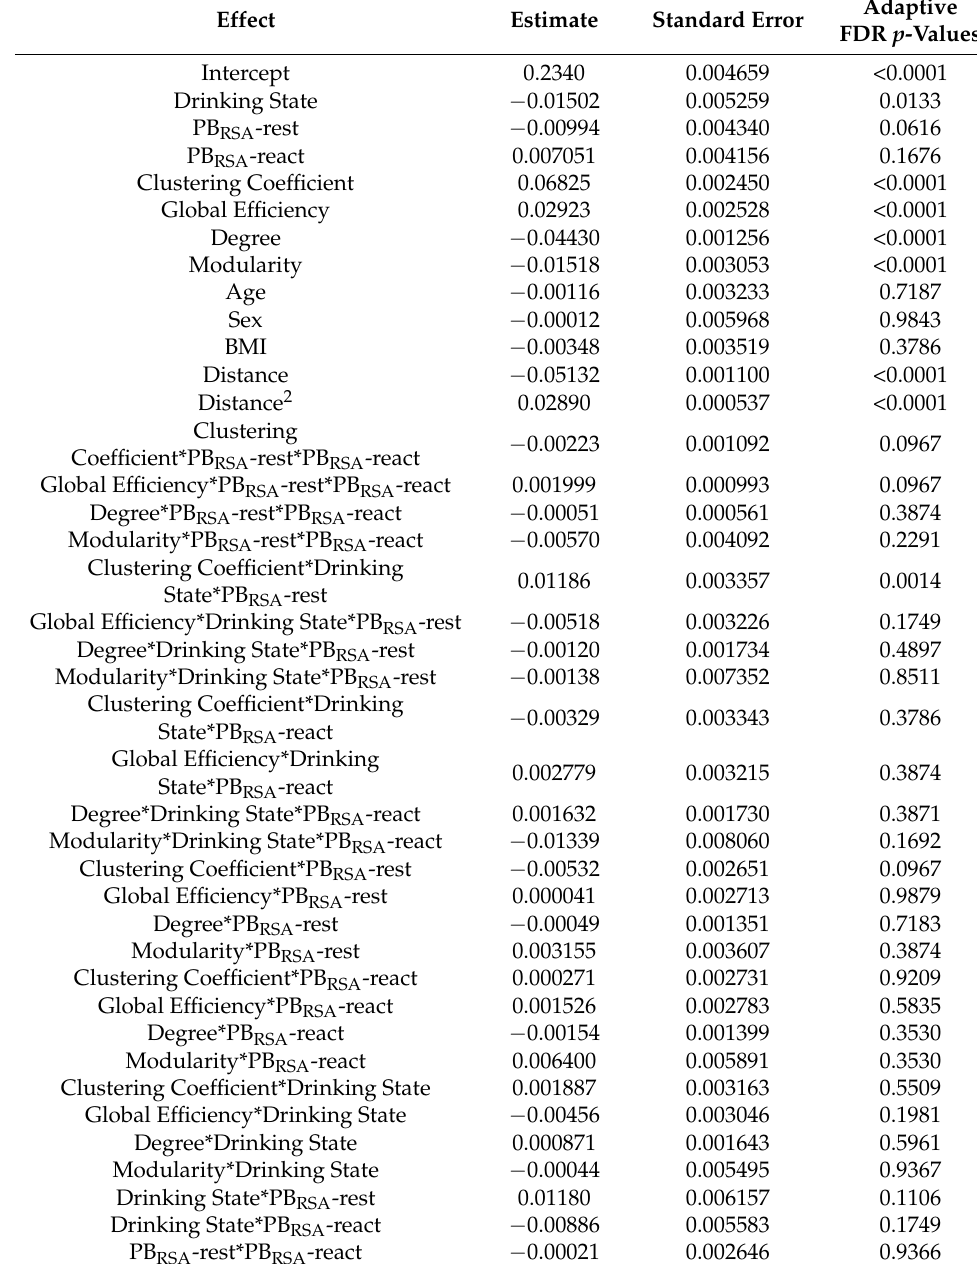
Table S2. Full mixed-effects model